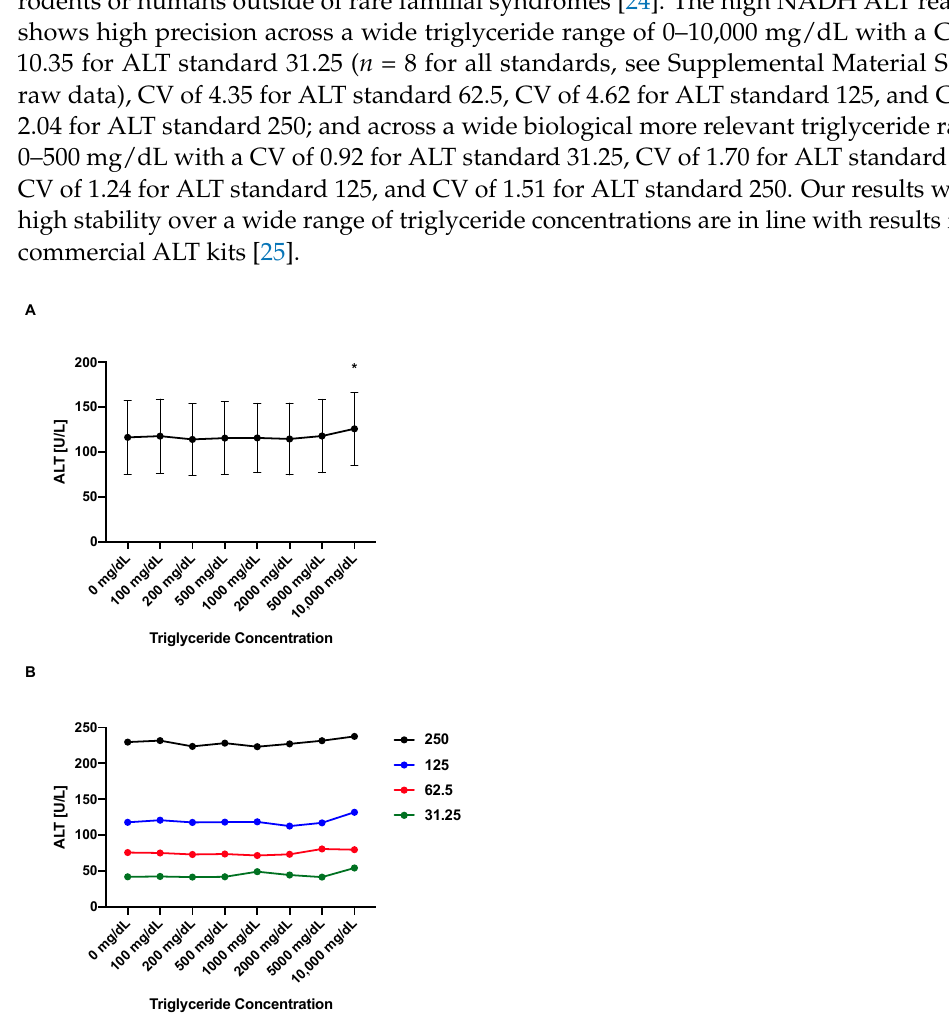
Figure 5. ALT values remain stable over a wide range of triglyceride concentrations. Purified triglycerides mixed with sterile water were added to respective ALT standards to achieve final ALT levels. ( A ) Mean ALT levels of ALT standards and triglyceride concentration. ( B ) Separate ALT levels for each ALT standard (250 in black, 125 in blue, 62.5 in red, and 31.25 in green) and triglyceride concentration. Results expressed as mean ± s.e.m. p values are determined by one-way paired ANOVA and Holm-Šídák’s post hoc test with the 0 mg/dL triglyceride group as the control group. * p < 0.05.